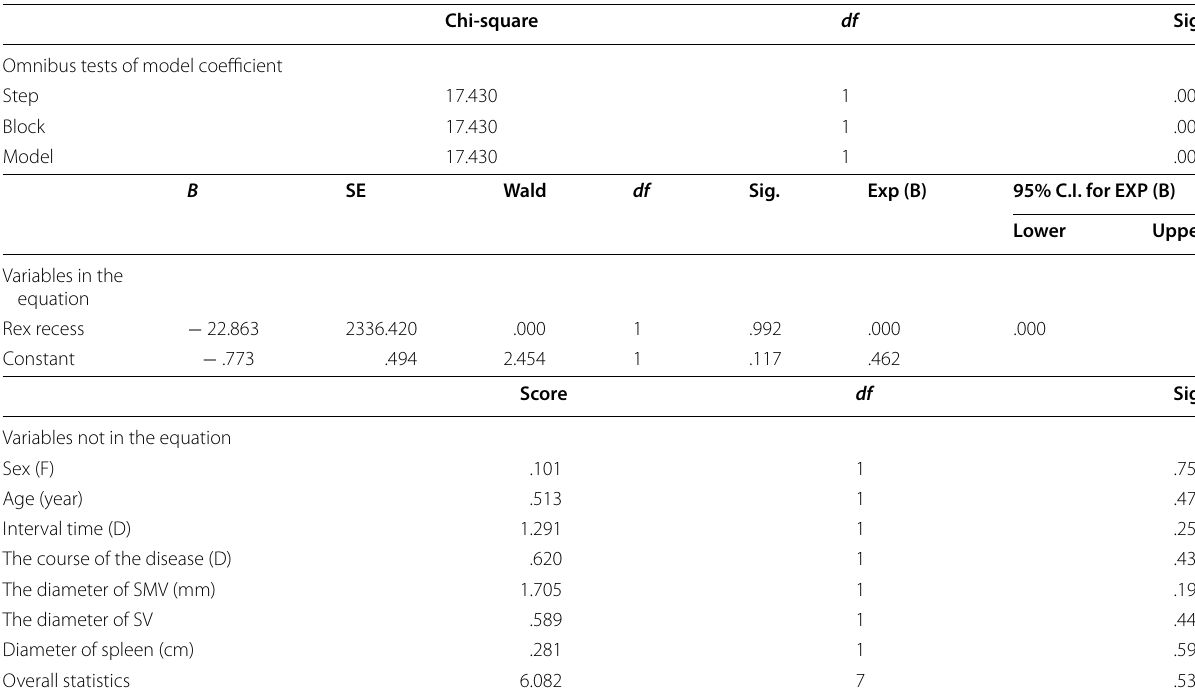
Table 2 Binary logistic regression of multivariate analysis for meso-Rex bypass